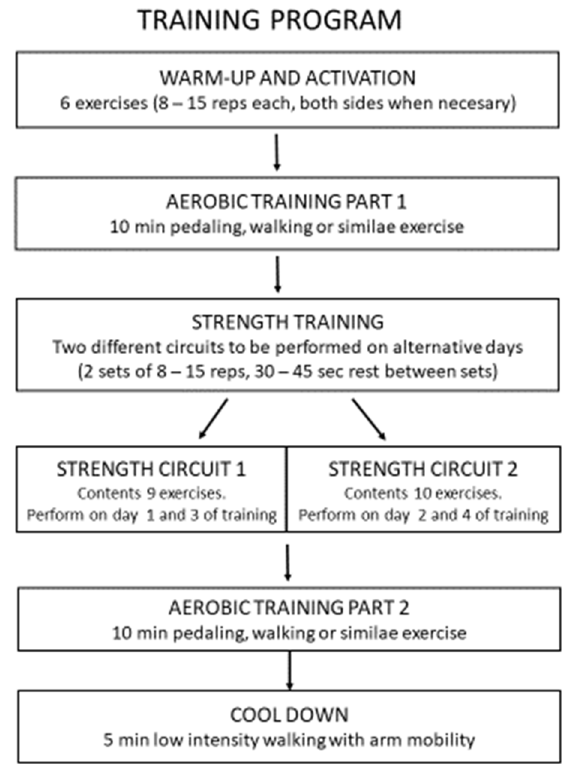
Figure 1. Exercise program description. Reps: repetitions, Min: minutes, Sec: seconds.